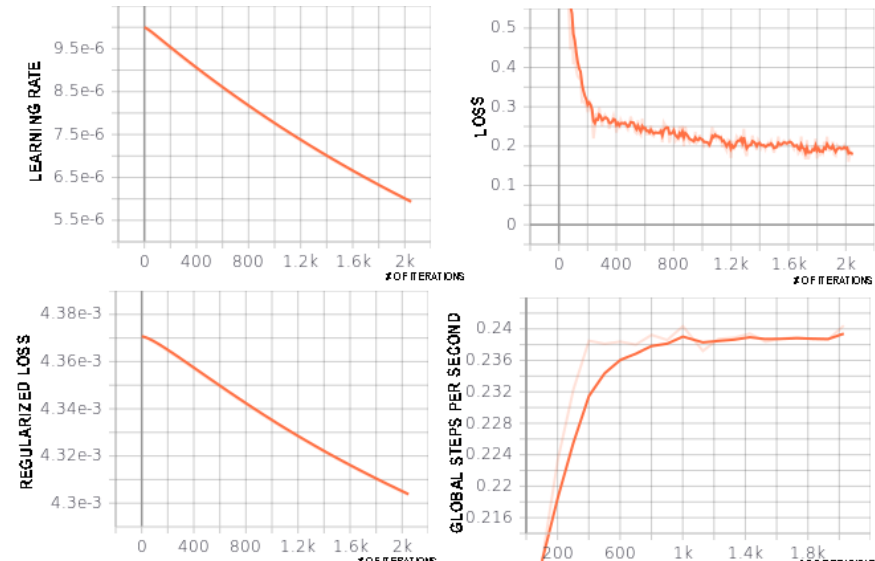
Figure 5. Training metrics are demonstrated. In the top left, the learning rate, in the top right, the loss function, in the bottom left, regularized loss, and in the bottom right, global steps per second metrics are demonstrated. The subfigures are created with Tensorboard. The horizontal axis is the increasing